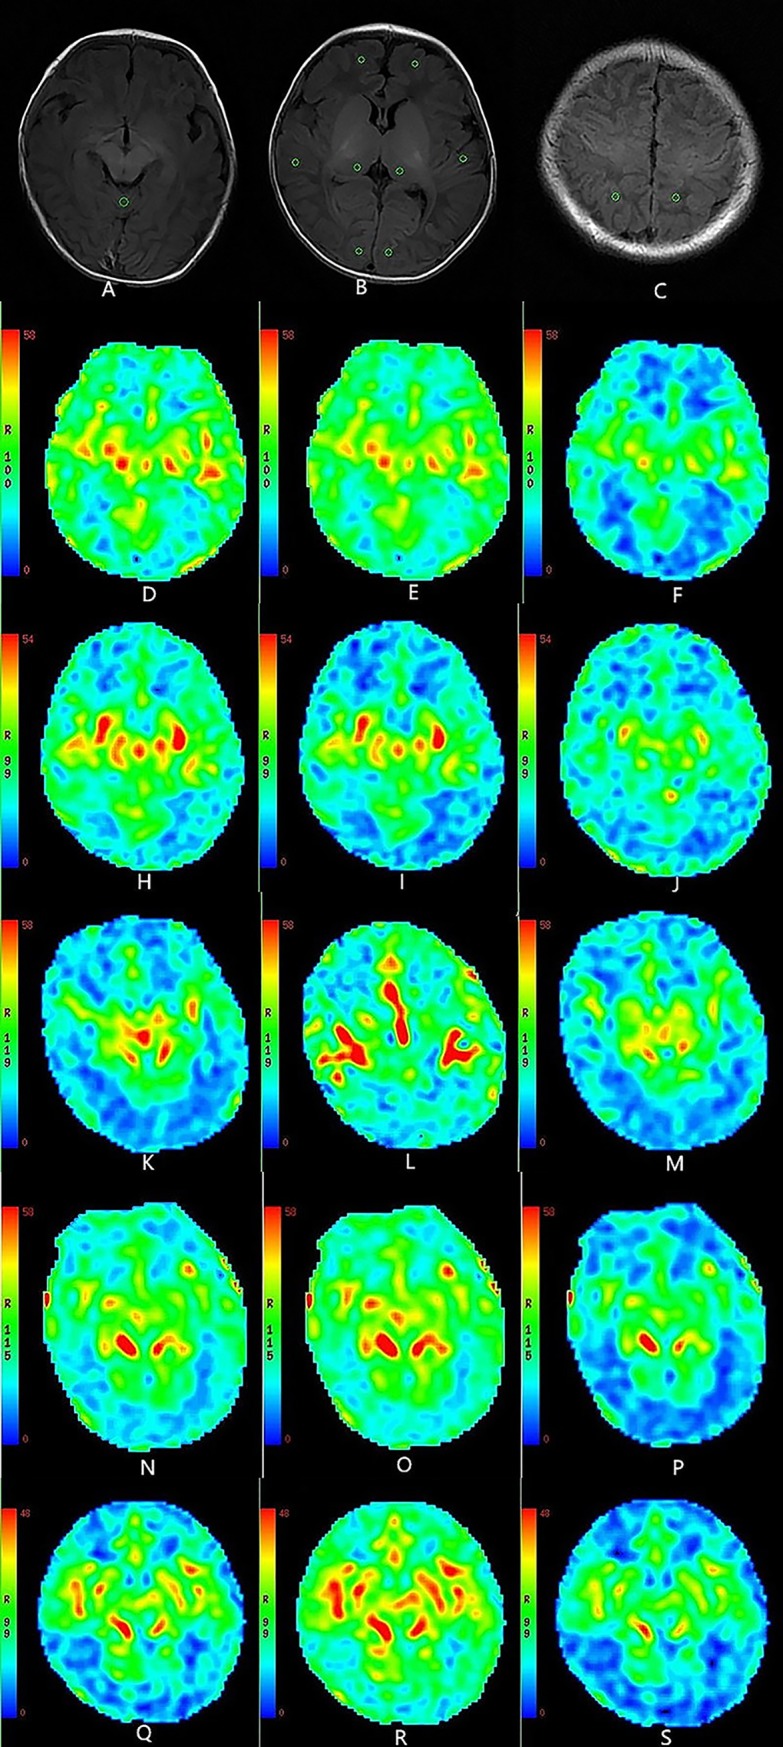
A-C. Schematic diagram of ROIs in the cerebellum, thalamus, occipital lobe, temporal lobe, frontal lobe and parietal lobe D-F. CBF map, healthy neonate, male, 11 hours old. Fig D. PLD value = 1025 ms; Fig E. PLD value = 1525 ms; Fig F. PLD value = 2025 ms. Red and green areas representing hyperperfusion in Fig D were greater than those in Fig E and F. H-J. CBF map, healthy neonate, female, 2 days old. Fig H. PLD value = 1025 ms, Fig I.PLD value = 1525 ms, Fig J. PLD value = 2025 ms. Red and green areas representing hyperperfusion in Fig H. were greater than those in Fig I and J. K-M. CBF map, healthy neonate, male, 5 days old. Fig K. PLD value = 1025 ms, Fig L.PLD value = 1525 ms, Fig M. PLD value = 2025 ms. Red and green areas representing hyperperfusion in Fig L were greater than those in Fig K and M. N-P. CBF map, healthy neonate, female, 12 days old. Fig N. PLD value = 1025 ms, Fig O.PLD value = 1525 ms, Fig P. PLD value = 2025 ms. Red and green areas representing hyperperfusion in Fig O were greater than those in Fig N and P. Q-S. CBF map, healthy neonate, male, 21 days old. Fig Q. PLD value = 1025 ms, Fig R. PLD value = 1525 ms, Fig S. PLD value = 2025 ms. Red and green areas representing hyperperfusion in Fig R were greater than those in Fig Q and S.